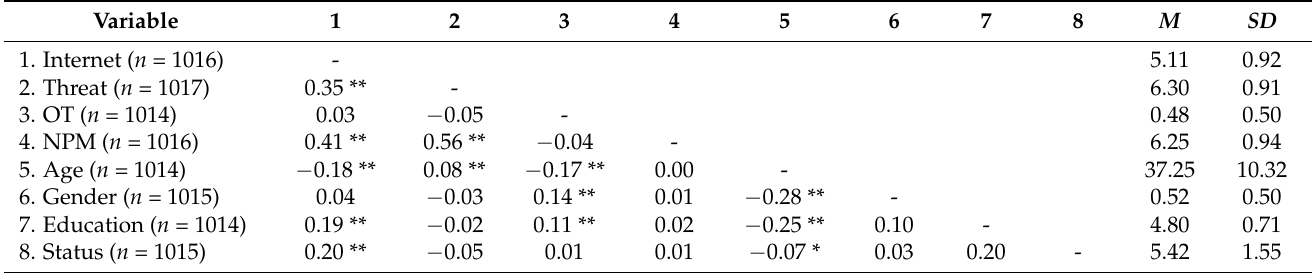
Table 1. Means, standard deviations, and intercorrelations among variables (Wave 1).